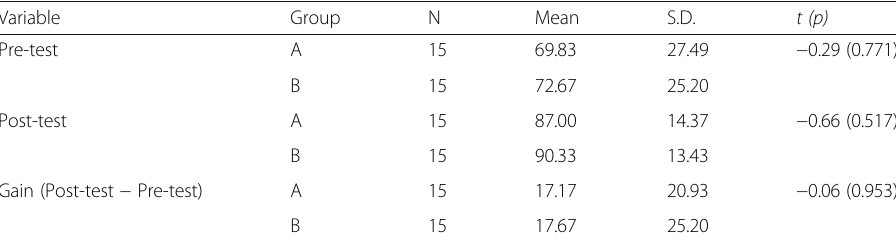
Table 6 The between-group result of t-test in the SFT scores Variable